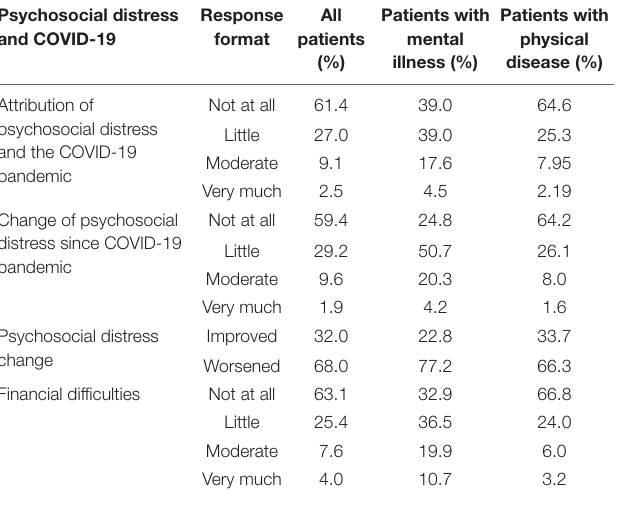
TABLE 3 | Subjective psychological distress connected with the COVID-19 crisis and financial difficulties in patients with physical and mental